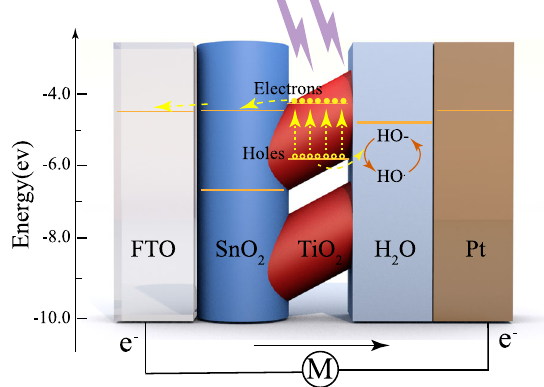
Fig. 5 Schematic energy band diagram and the electron-transfer processes for the STNMAs/H 2 O